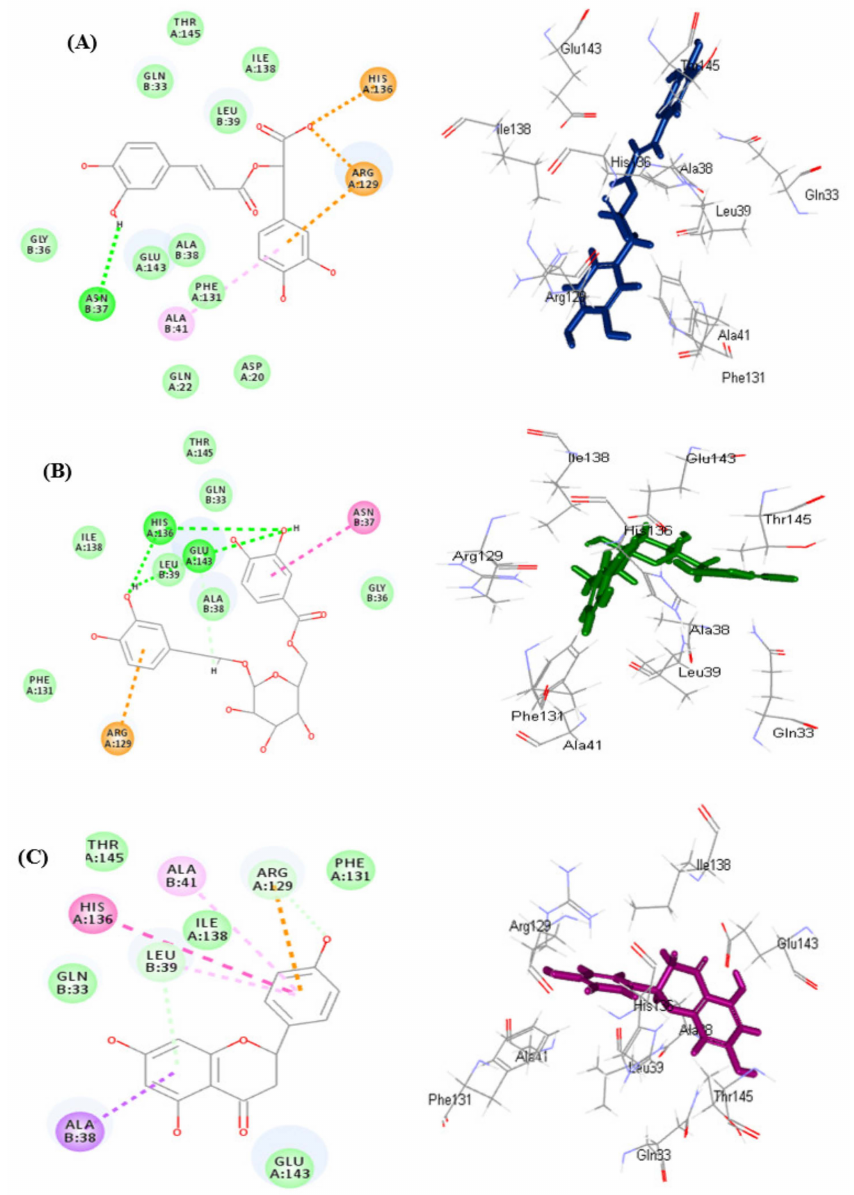
Figure 5. 2D and 3D of rosmarinic acid ( A ), fuhsioside ( B ), and naringenin ( C ) within the active sites of daf2 protein employing pH-based ionization mode; H-bonds (heavy green dotted bonds); C-H bonds (light green dotted bonds); π -ionic bonds and attractive charges (orange dotted bonds); π - δ bond (violet dotted bonds); π - π bonds (heavy purple dotted bonds) and π -alkyl bonds (light purple dotted